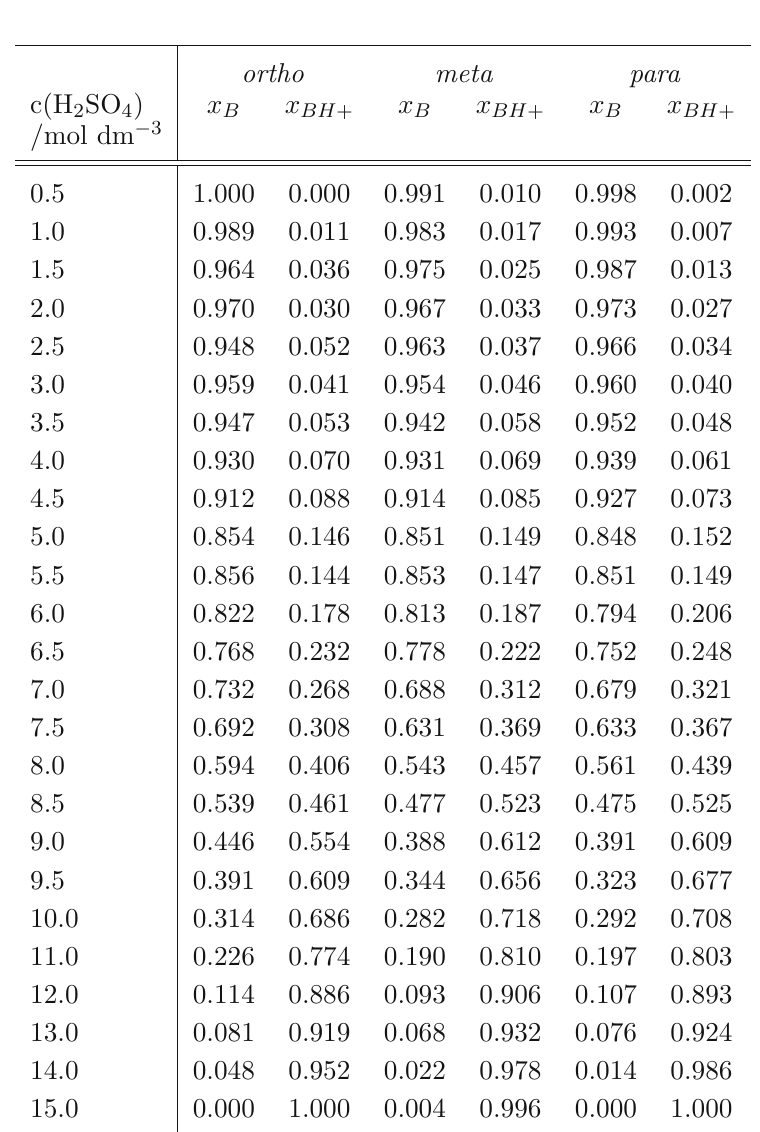
Table 4 Mole fractions of B and BH + of